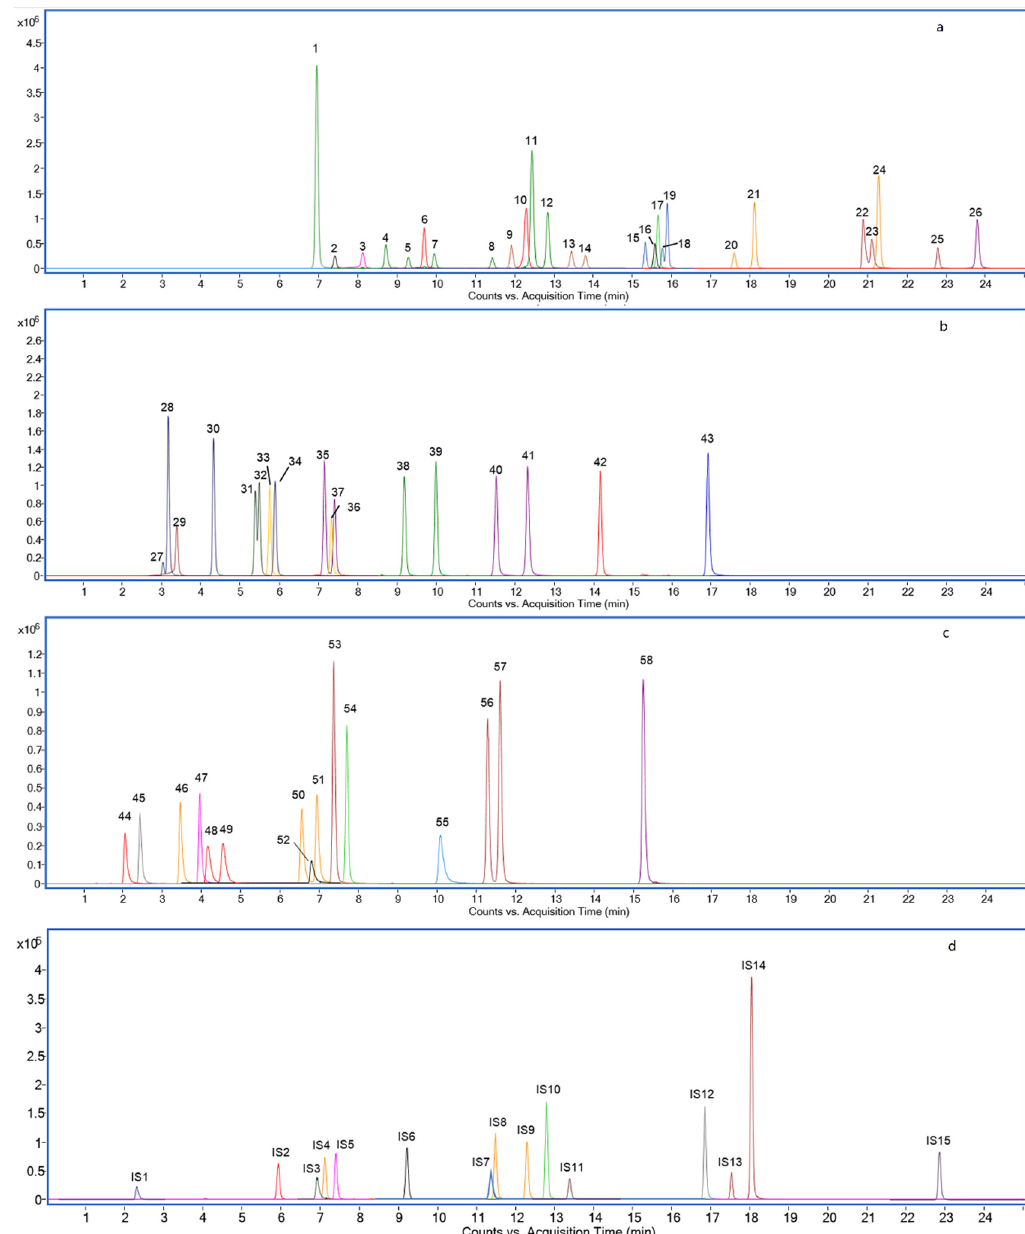
Figure 3. Extracted ion chromatograms of 26 unconjugated ( a ), 8 glycine-conjugated and 9 taurine- conjugated BAs ( b ), 5 taurine-sulfated, 5 glycine-sulfated, and 5 sulfated BAs ( c ), and 15 deuterium (D)-labeled BAs as Internal Standards ( d ). (1) UCA (2) 7,12-diketoLCA (3) DHCA (4) ω -MCA (5) α -MCA (6) 7-DHCA (7) β -MCA (8) γ -MCA (9) MDCA (10) 3-DHCA (11) alloCA (12) CA (13) UDCA